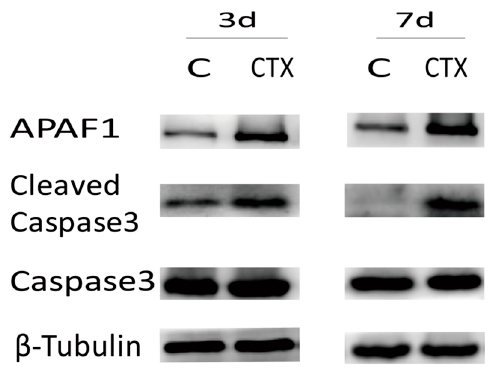
Figure 4. Cyclophosphamide activated the classical apoptosis signaling pathway: expression of APAF-1, cleaved caspase-3 and total caspase-3. More than three ovarian samples of each group were analyzed by Western blot and we chose the representative images in the figure.